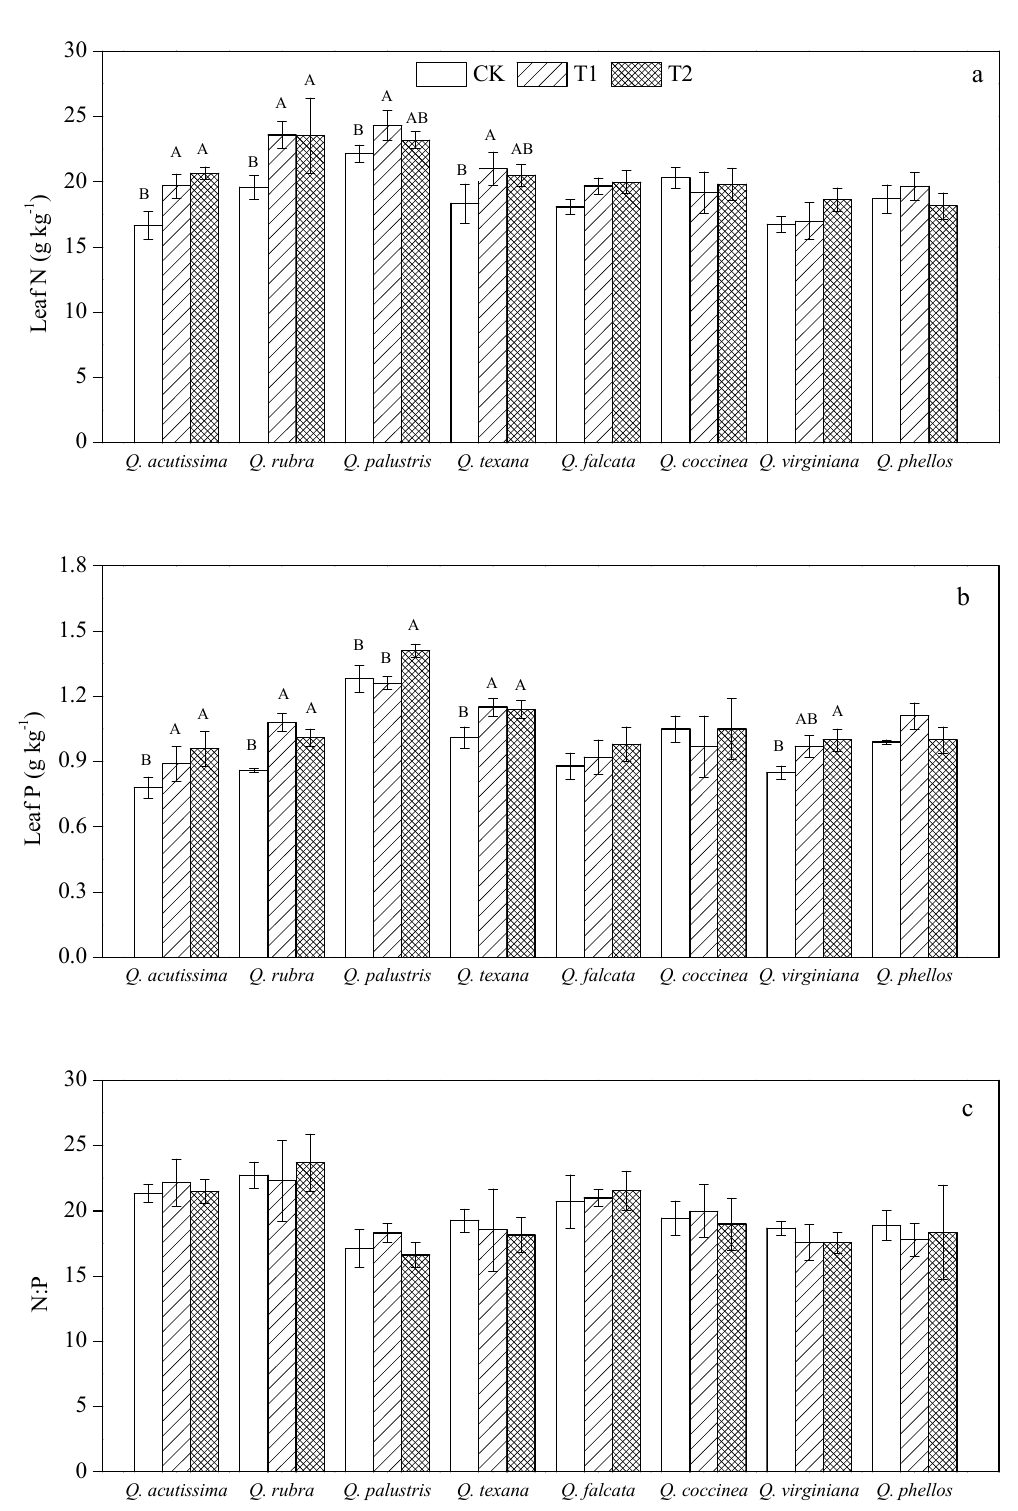
Figure 1. Effects of wind on leaf N, P stoichiometry (means ± standard deviation) for Quercus species. ( a ) Leaf N concentration; ( b ) Leaf P concentration; ( c ) Leaf N:P. For each species, different capital letters on the bars indicate significant differences among treatments ( p < 0.05). CK : control, T1 : about 4 m s − 1 wind speed, T2 : about 6 m s − 1 wind speed.